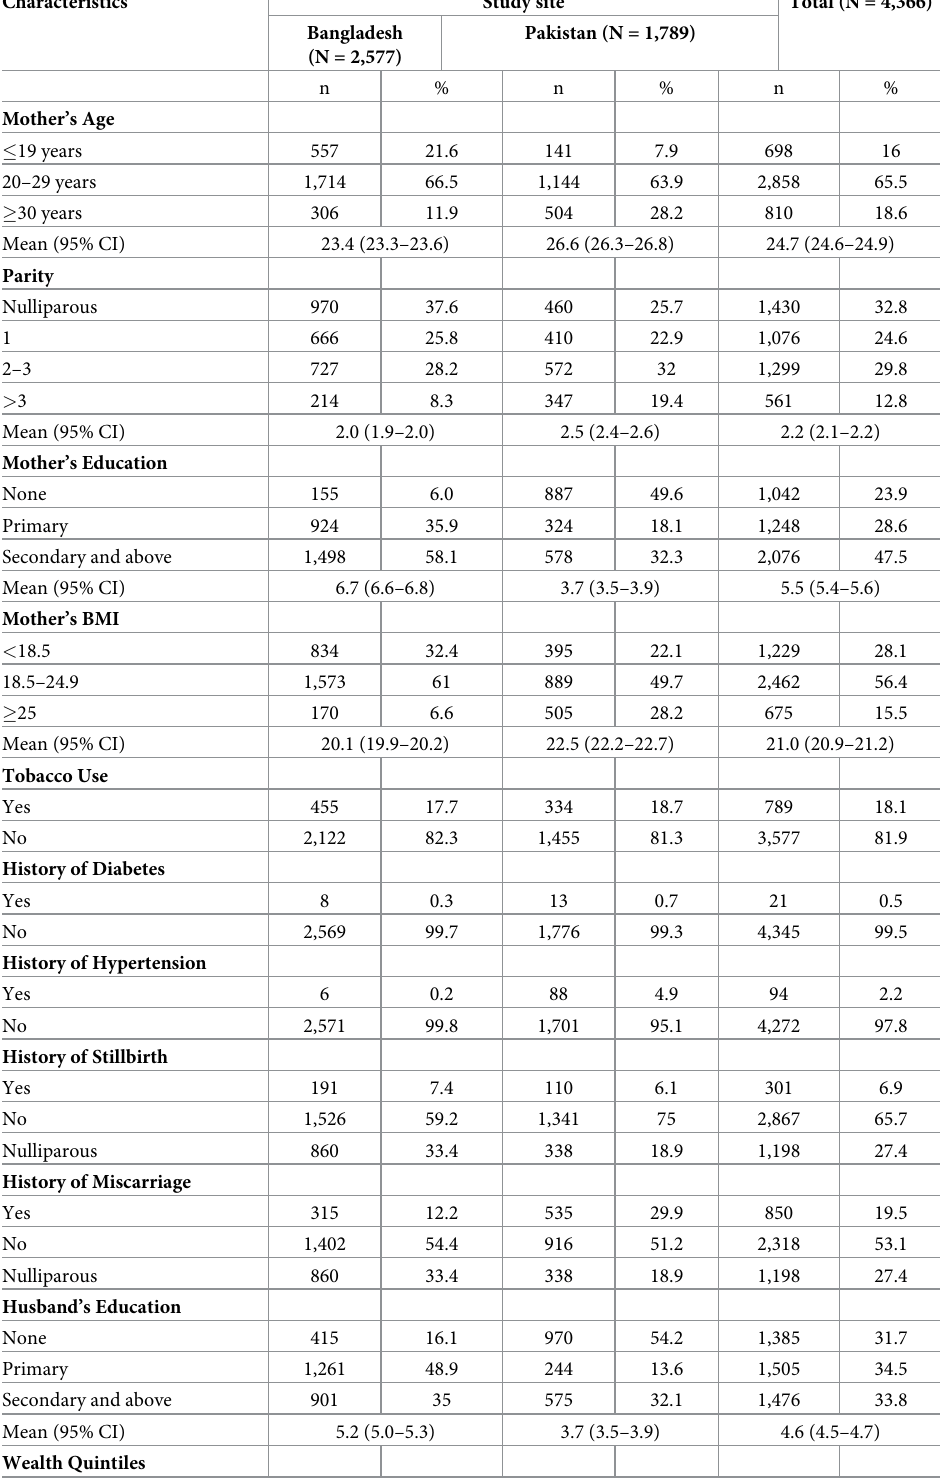
Table 1. Selected baseline characteristics of study population by study site (N = 4,366).